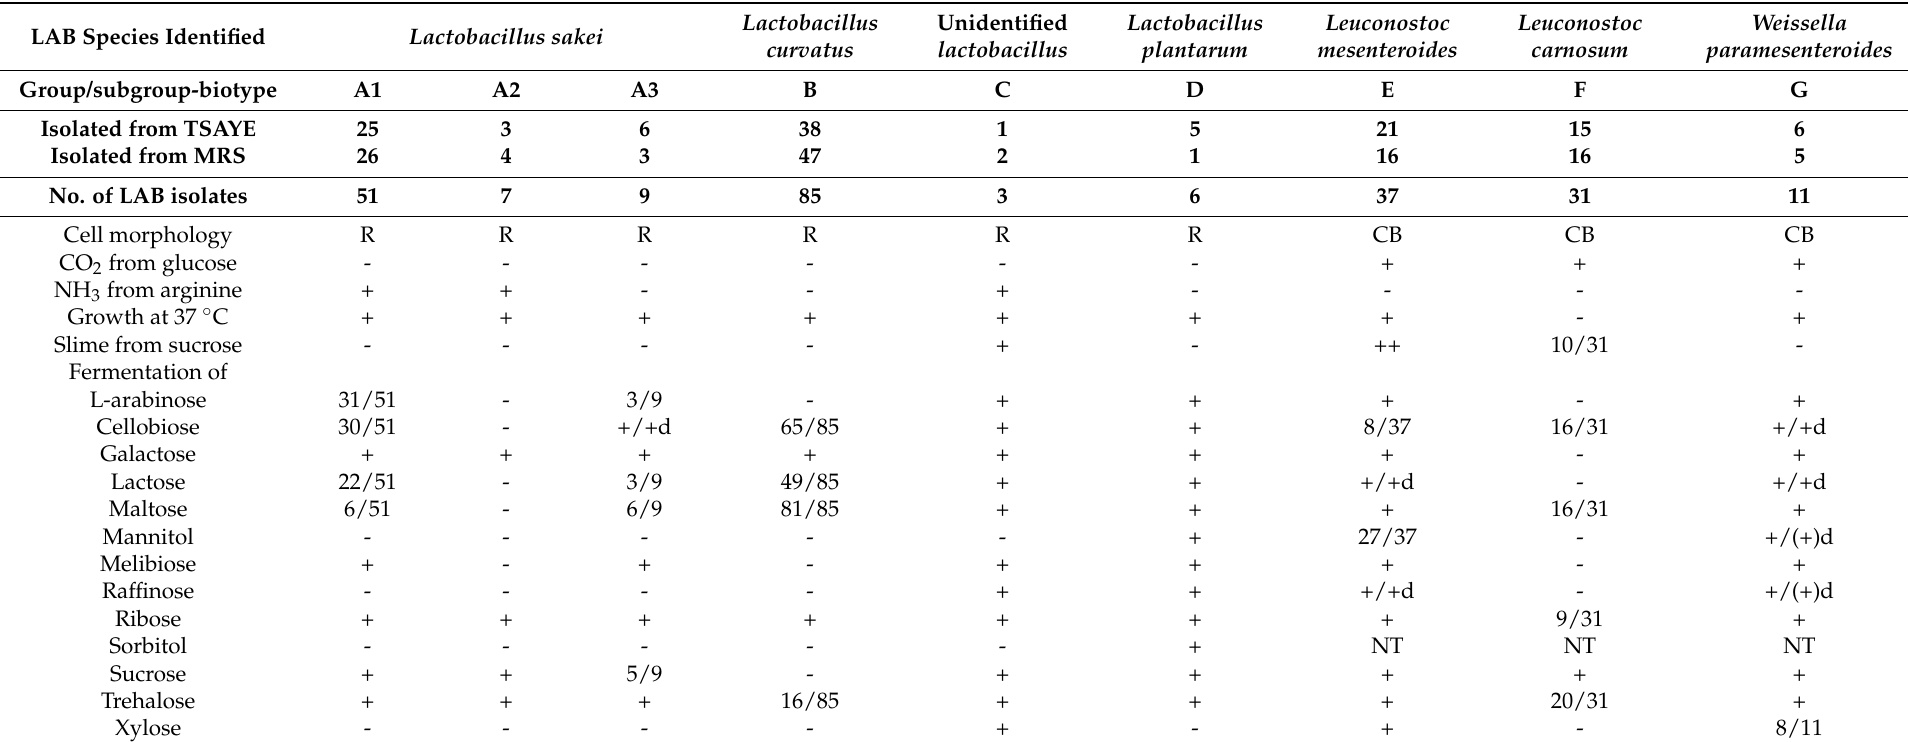
Table 2. Biochemical identification of 240 LAB isolates from frankfurters formulated with or without organic acid salts, vacuum-packaged and stored at 4 ◦ C or 12 ◦ C. LAB Species Identified Group/subgroup-biotype Isolated from MRS